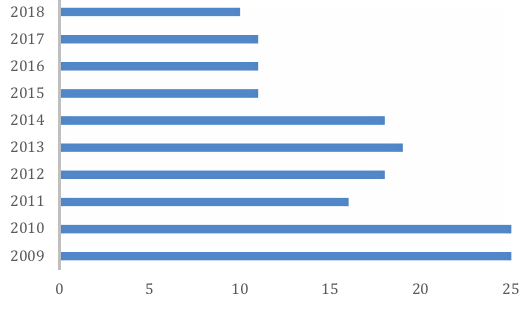
Figure 4. Public notices by